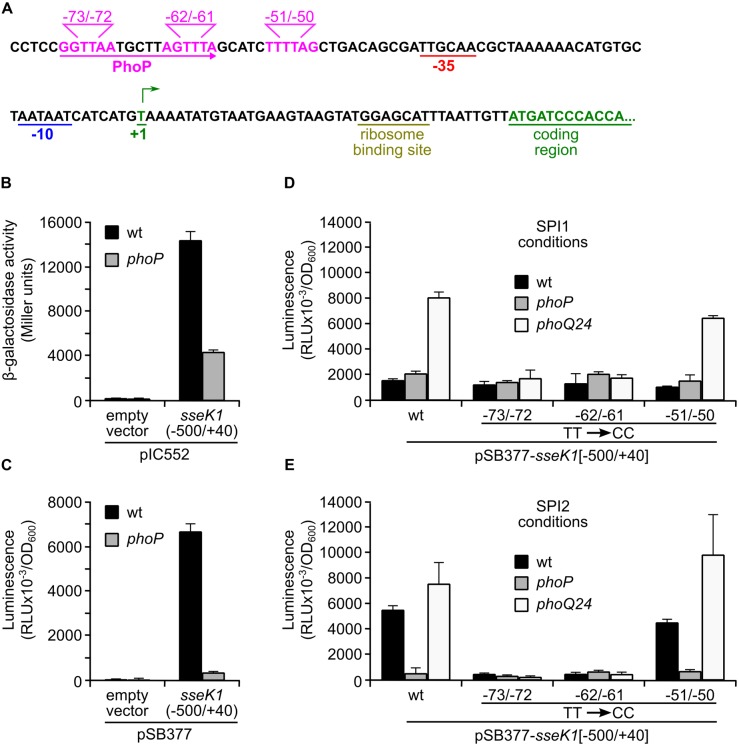
Identification of a PhoP box in the promoter of sseK1. (A) Analysis of the promoter region of sseK1. The sequence surrounding the transcriptional start site (+1) is shown. The start of the coding sequence, the putative ribosomal binding site and the consensus sequences for σ70-dependent transcription (-10 and -35) are indicated. Putative PhoP-binding motifs are marked in pink and a putative PhoP-box is underlined with an arrow. A fragment of DNA containing the promoter region and 5′ untranslated region of sseK1 (-500/+40) was inserted into plasmid pIC552 to generate a lacZ transcriptional fusion (B) and into plasmid pSB377 to generate a luxCDABE transcriptional fusion (C). These plasmids and the corresponding original empty vectors were introduced into S. enterica serovar Typhimurium strain 14028 (wt) or a phoP-null mutant, and β-galactosidase activities or luminescence, respectively, were measured in cultures grown to stationary phase in liquid LPM at pH 5.8. Luminescence was also measured from the wt, phoP and phoQ24 strains carrying derivatives of pSB377 with the promoter region of sseK1 or variants with the indicated mutations and grown under SPI1 (D) or SPI2 (E) inducing conditions. RLU: relative light units.